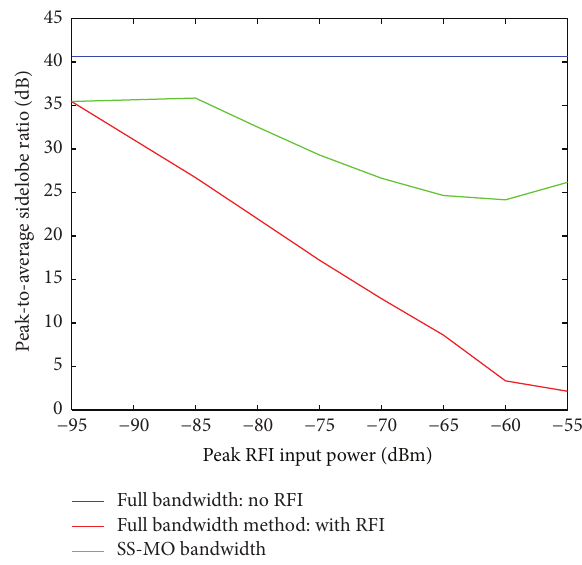
Figure 9: The PSLR results of the narrowband RFI experiment. The PSLR measured for the SS-MO algorithm is maintained at a higher level as the narrowband interference power increases.